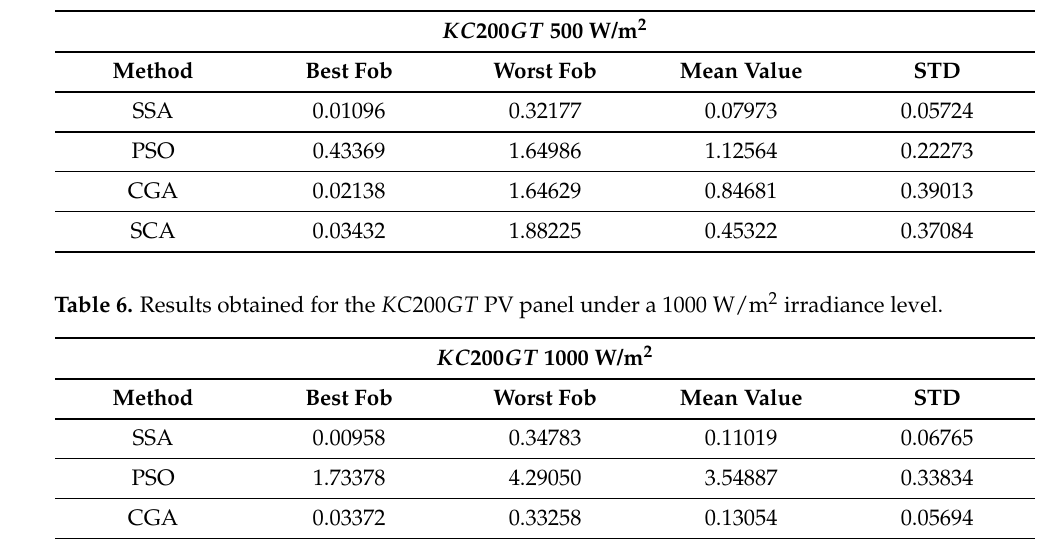
Table 5. Results obtained for the KC 200 GT PV panel under a 500 W/m 2 irradiance level.